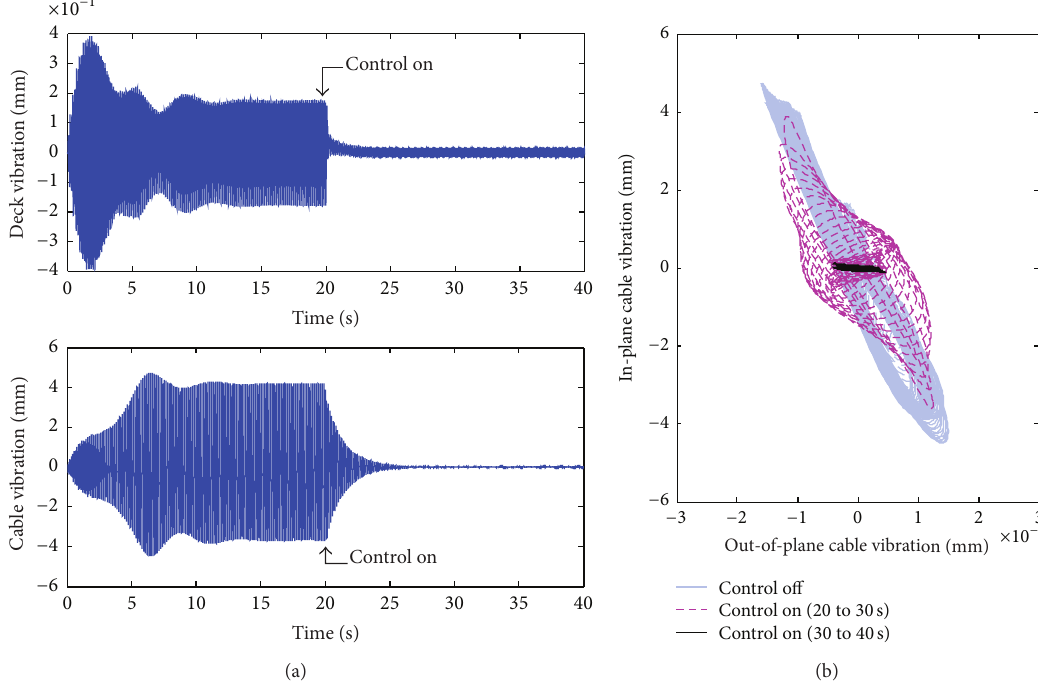
Figure 12: (a) Evolution in time of the vertical deck vibration and the in-plane cable vibration at L /2 (control on at 20 s); (b) cable trajectory at L /2 before and after control (case of principal parametric excitation).